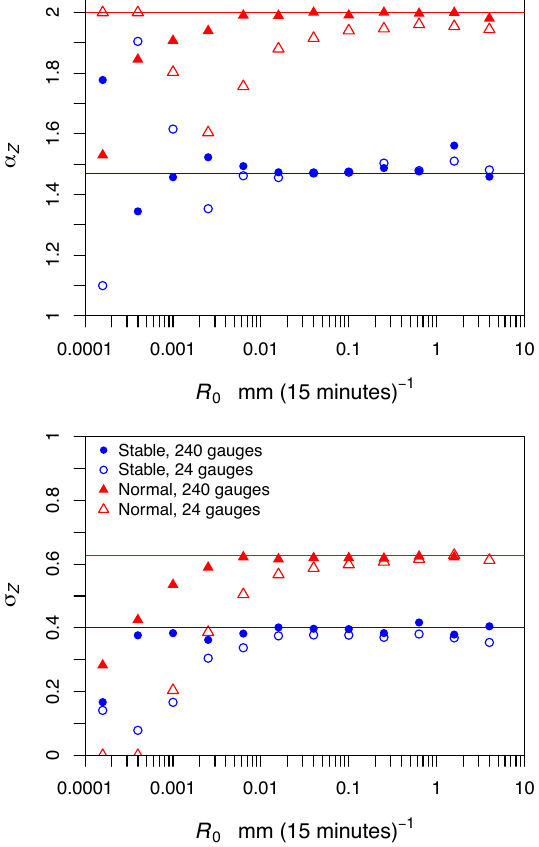
Fig. 10. Stable distribution parameters α Z and σ Z for Z = ln Y + against large-scale areal-averaged rainfall rates R 0 for R 0 > 0 as es- timated from simulated rainfall using the rainfall-independent mod- els SI σ /RI σ /LS (log-stable) and SI σ /RI σ /LN (log-normal). The blue and red horizontal lines show the assumed values of α Z (upper panel) and σ Z (lower panel) for models SI σ /RI σ /ST and SI σ /RI σ /LN, respectively. The solid symbols show the parameter values estimated using 240 “gauges”, represented by 240 grid cells in finest resolution field (approximately 15cm × 15cm). The open symbols show the parameter values estimated using 24 such